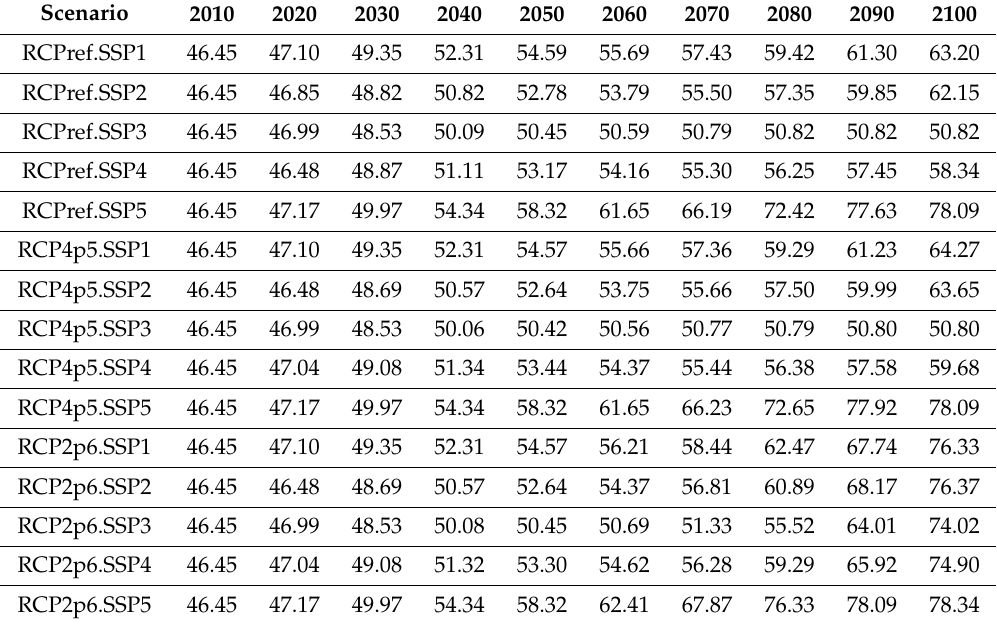
Table A15. Industrial roundwood harvest (millions of m 3 / year, under bark).